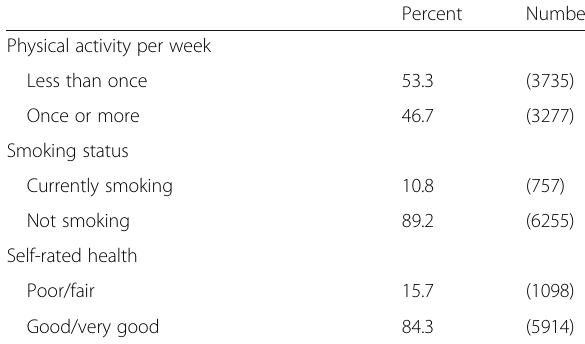
Table 1 Descriptive characteristics of the participants ( n =